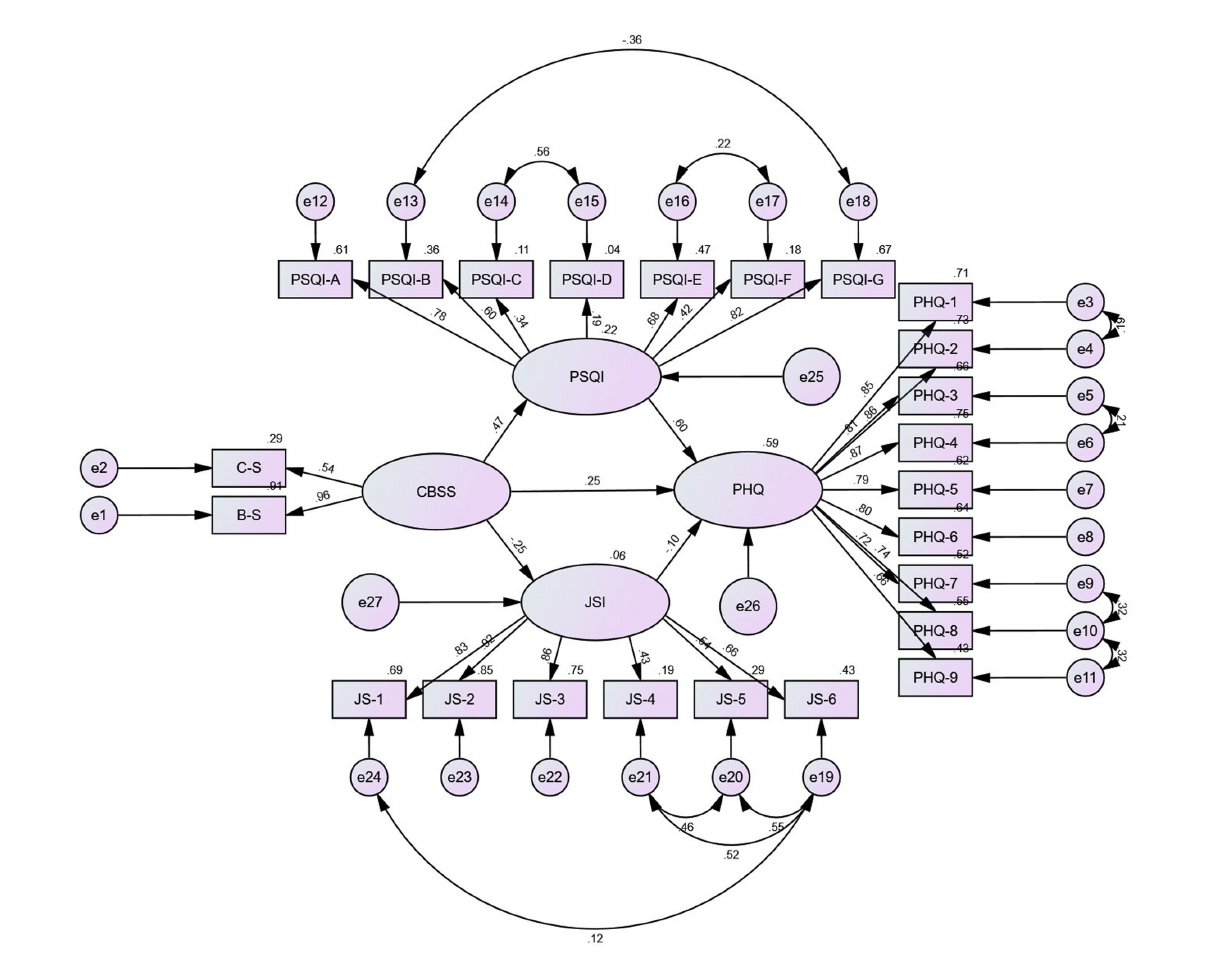
FIGURE 2 Results of the SEM analysis of the effects of sleep quality and job satisfaction mediate the association between work stress and depression among the sample of technical secondary school and below. All the coefficients in the figure are standardized and significant at 0.001 level. Except that the standardized coefficient of JSI to PHQ is significant at the level of